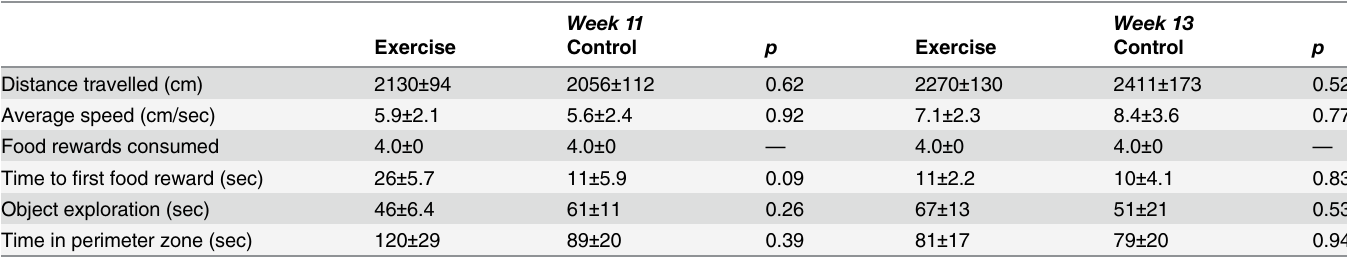
Table 1. Open Field Assessment Measures from Weeks 11 and